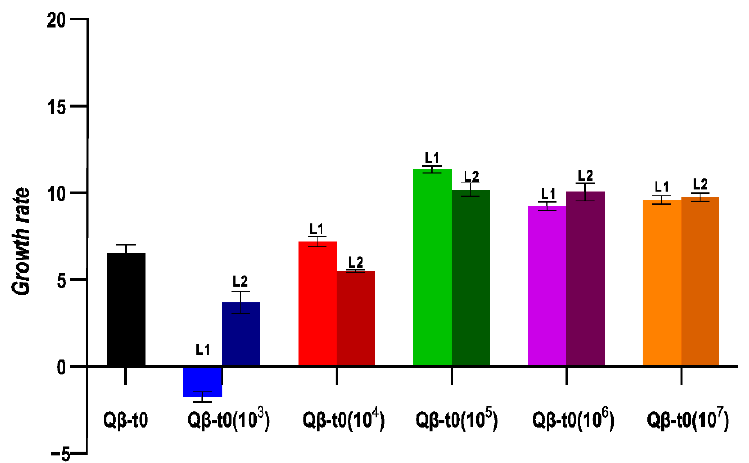
Figure 5. Growth rate values at 43 ◦ C obtained for the evolutionary lineages propagated from Q β -t0. The value obtained for the ancestor is also shown. Each bar represents the average of three replicas, and the error bars correspond to the standard deviation.